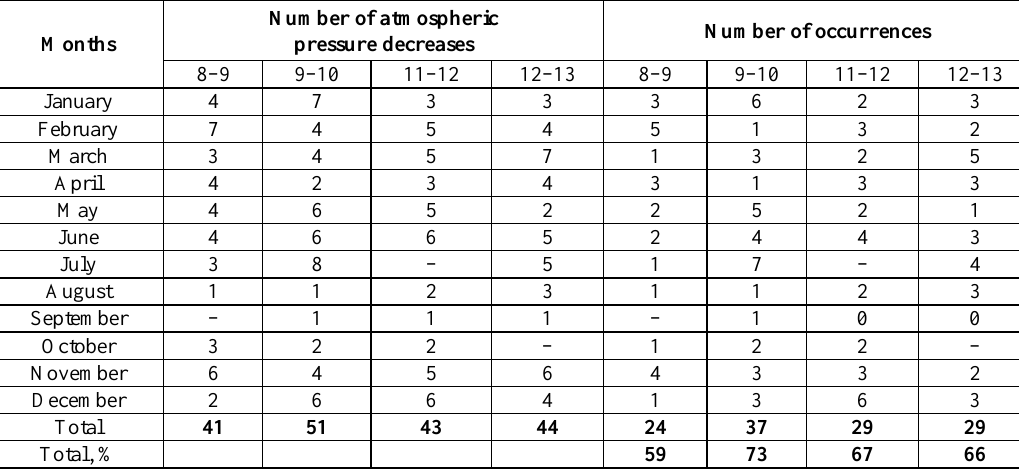
Fig. 1. Linear regressions between HCRF and atmospheric pressure in different seasons during 2004–2005: a – winter; b – spring; c –summer; d – autumn Table 3. Efficiency of prognostic connection between HCRF decrease at 1.2–1.6 MeV energy interval and atmospheric pressure decrease at various time intervals in Vilnius in